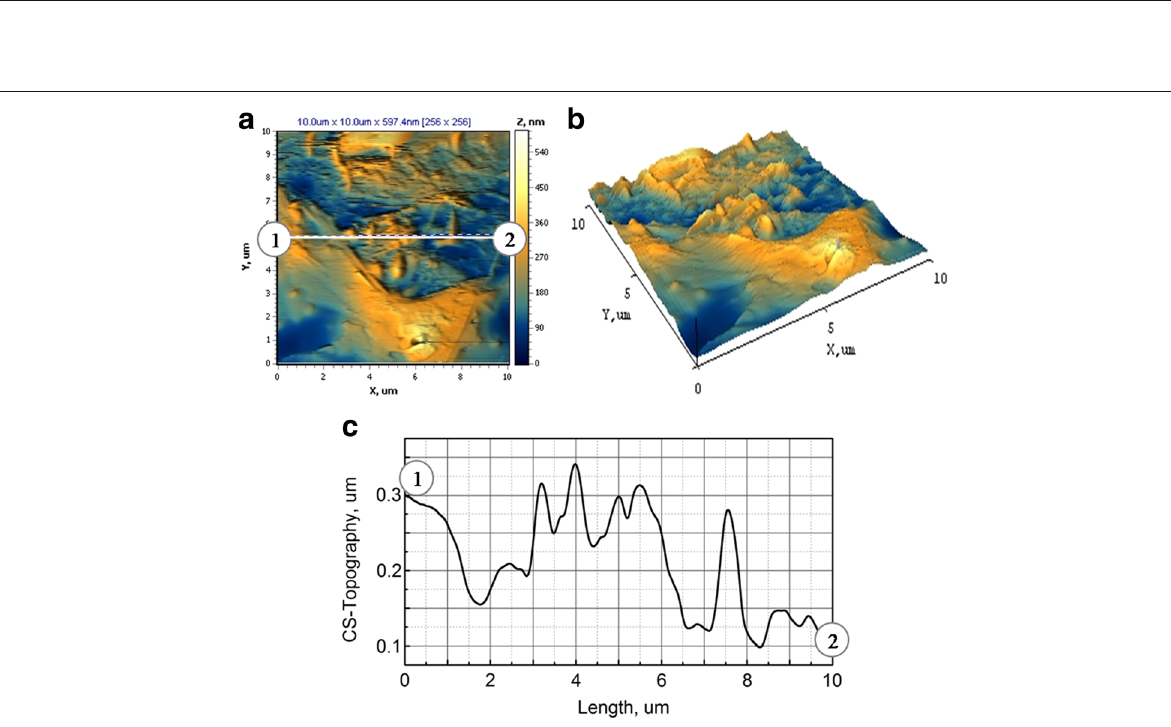
Fig. 11 a 2D and b 3D maps of the surface and c cross-sections between markers 1 and 2 for part B of Fe-Co-Mo coating with thickness